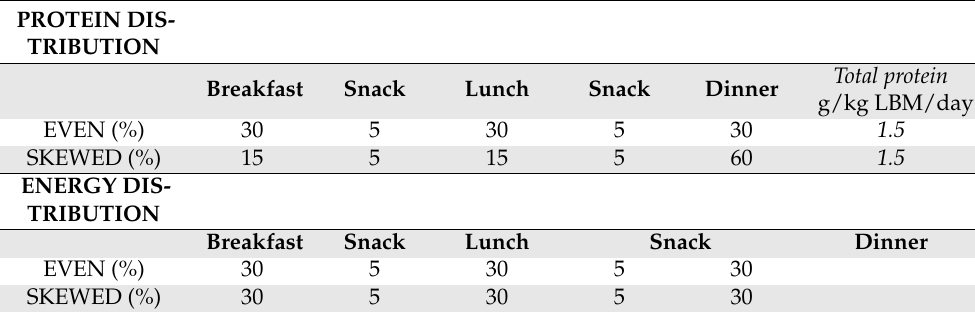
Table 2. Meal distribution during the trial